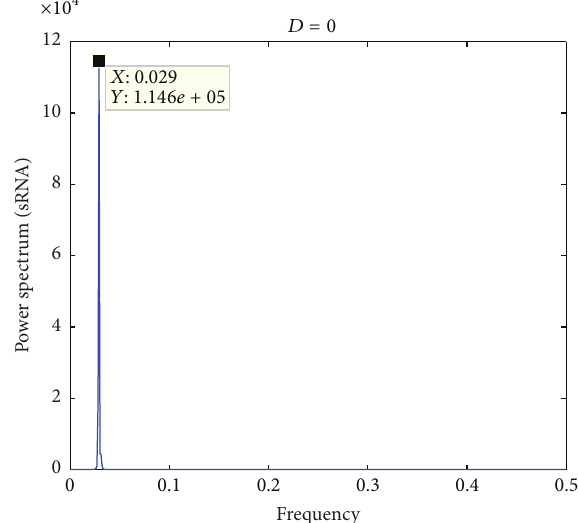
Figure 4: The power spectrum of small RNA presented in Figure 2.